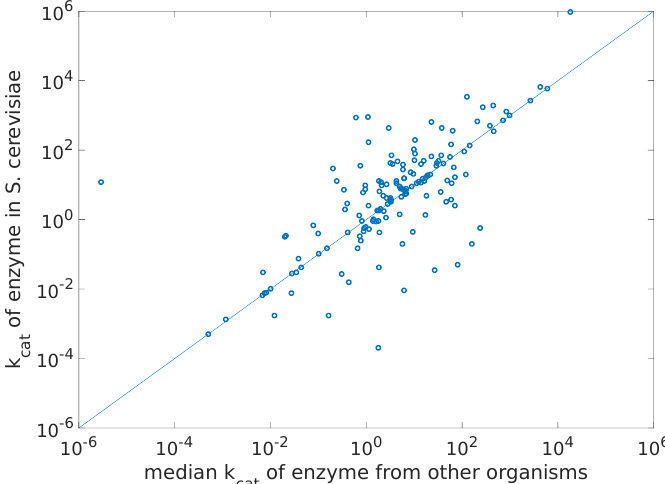
Figure 2. Turnover rates in yeast versus the median k cat values from other